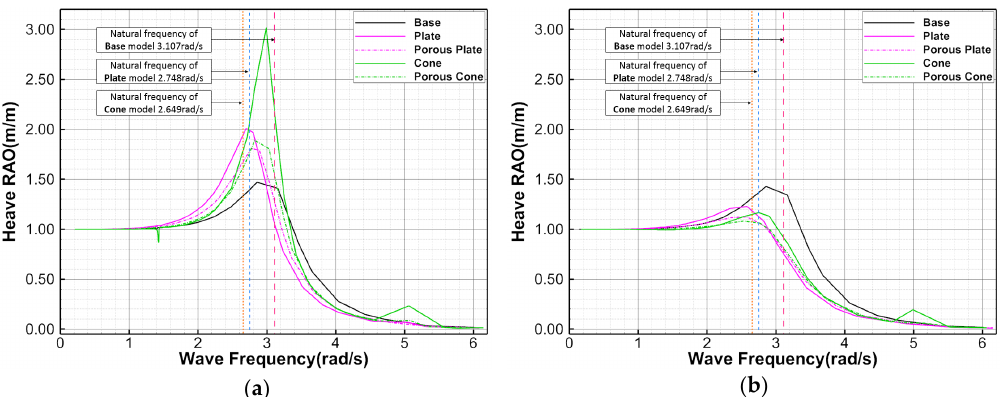
Figure 14. Heave RAOs estimated from the potential ‐ based motion analysis of the light buoys (a) without and (b) with the consideration of viscous damping.